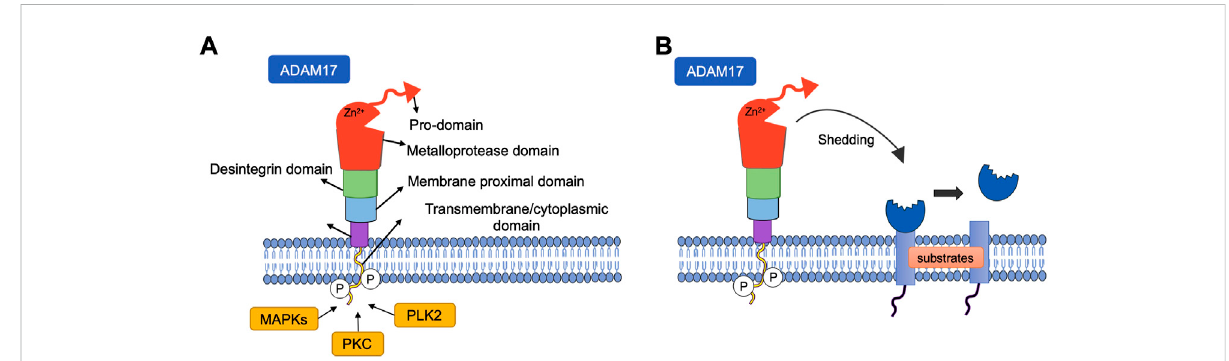
FIGURE 1 (A) Structure of ADAM metallopeptidase domain 17 (ADAM17). The structure of ADAM17 can be divided into six domains, all of which have distinct functions. CANDIS: Conserved ADAM-seventeen Dynamic Interaction Sequence. (B) Shedding of cell surface proteins induced by ADAM17. ADAM17 function is regulated byphosphorylationof thecytoplasmic domain byintracellular kinasessuch as protein kinase C (PKC), Polo-like kinase 2(PLK2), Mitogen Activated Protein Kinase (MAPKs). Various substrates, including receptors, cytokines and growth factors are targets of this protease, undergoing cleavage and release in the soluble